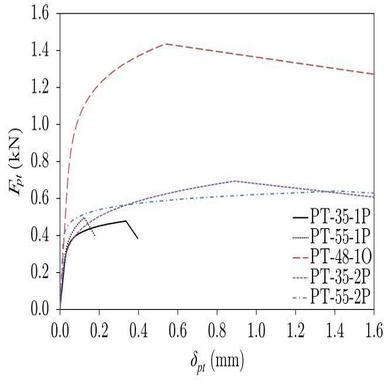
Pull-through load-deformation curves from proposed model for different test groups.